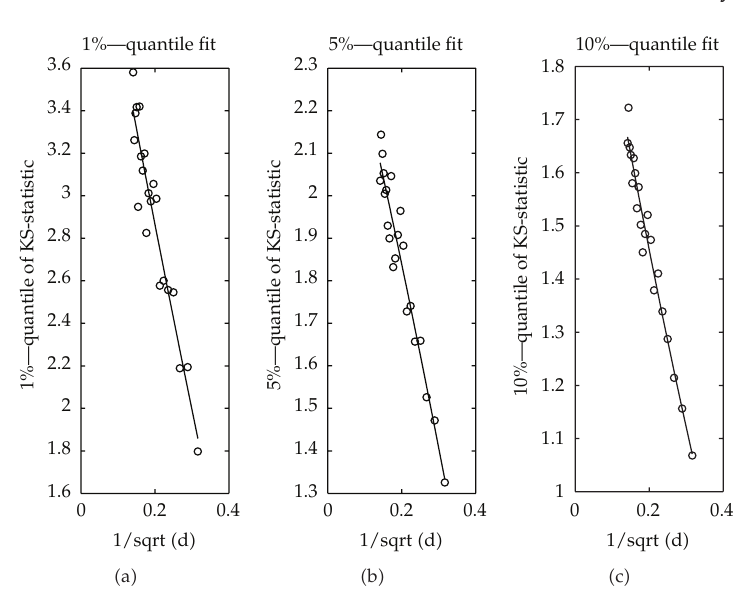
Figure 1: Quadratic curve fit for the percentiles of the K-S type statistic KS d (cid:4) z (cid:7) given by (cid:4) 2.17 (cid:7) .